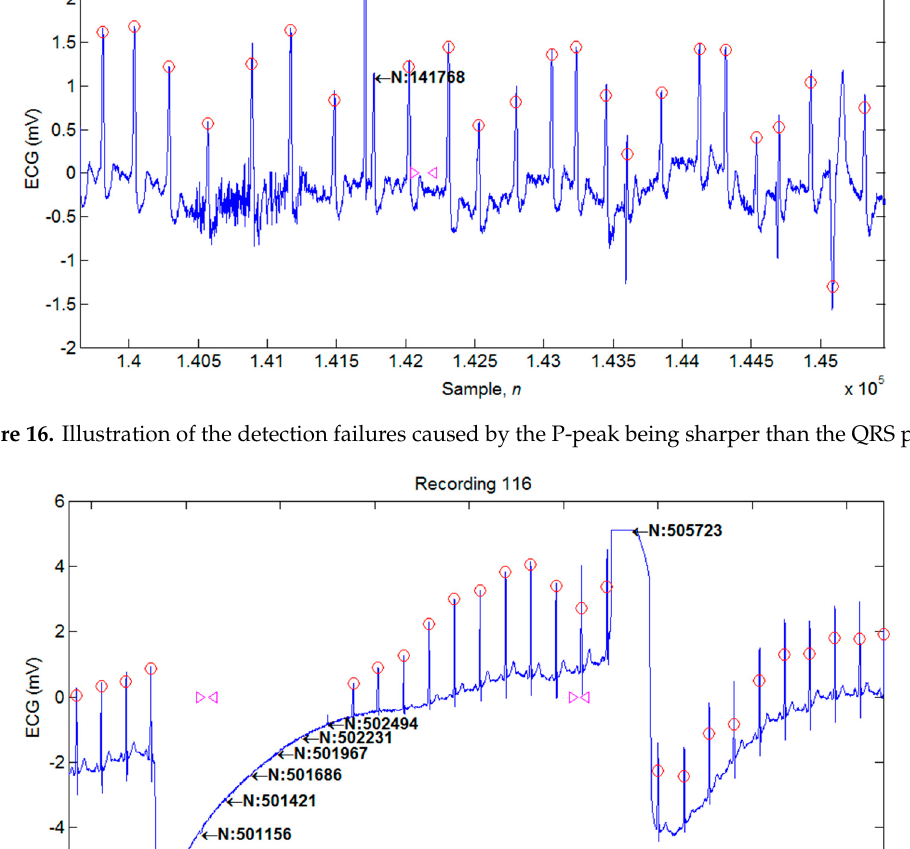
Figure 17. Illustration of the detection failures caused by Not QRS peaks being annotated as QRS peaks by the MIT-BIH Arrhythmia Database.